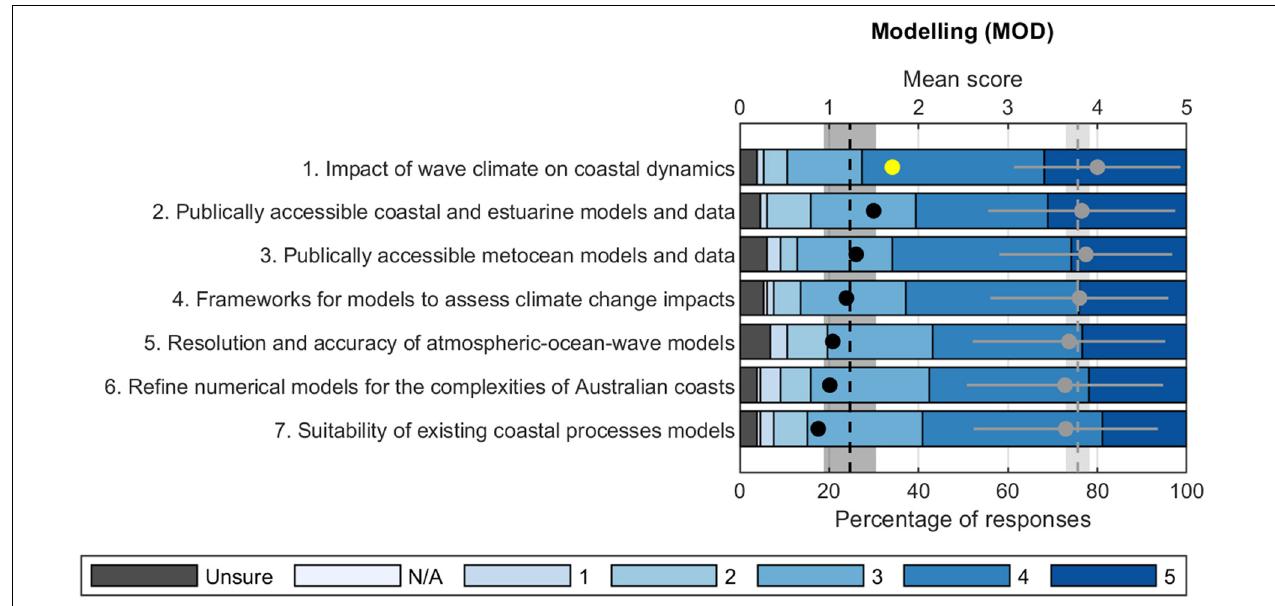
FIGURE 7 | Stacked bar plot showing the distribution of Stage 3 respondent scores for priorities in the Modelling (MOD) category. See Figure 5 for full